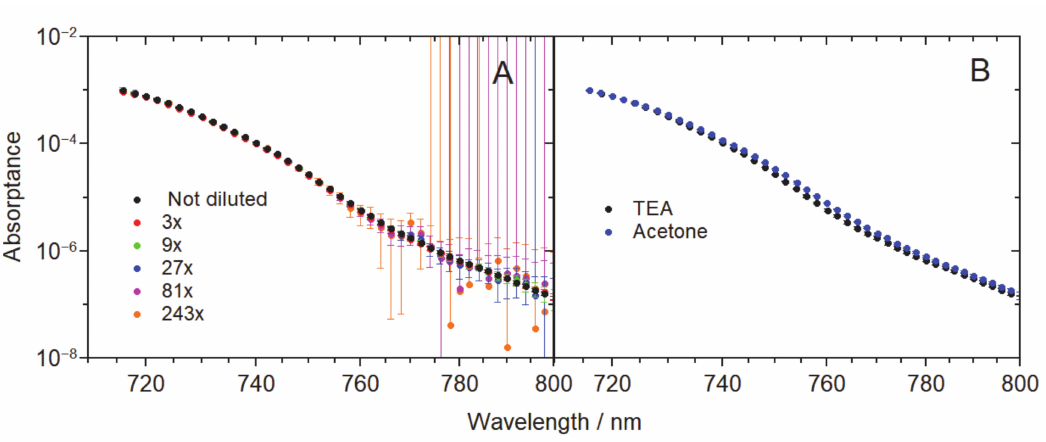
Figure 4. ( A ) Comparison of the fluorescence excitation spectra of Chl a in TEA with various degrees of dilution, as indicated in the legend. The initial concentration roughly corresponds to that in Figure 1. ( B ) Comparison of the excitation spectra of Chl a in TEA (black dots) and acetone (blue dots). In both panels, the vertical scale is normalized according to the Q y peak at 661.5 nm equal to unity.